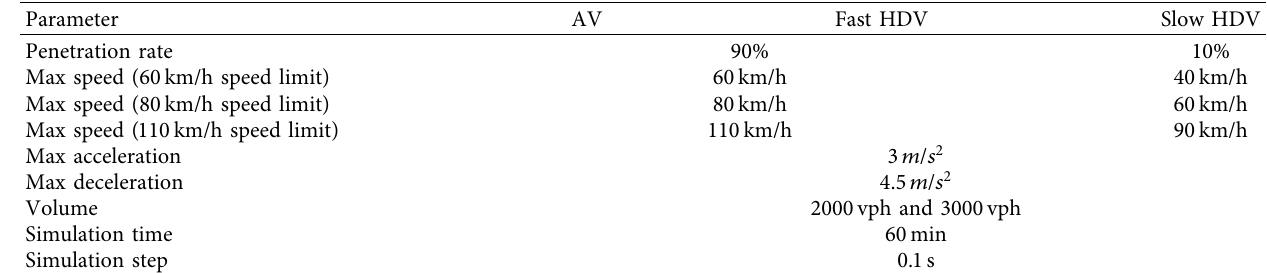
Figure 16: Simulation network. Table 3: Parameters in simulation